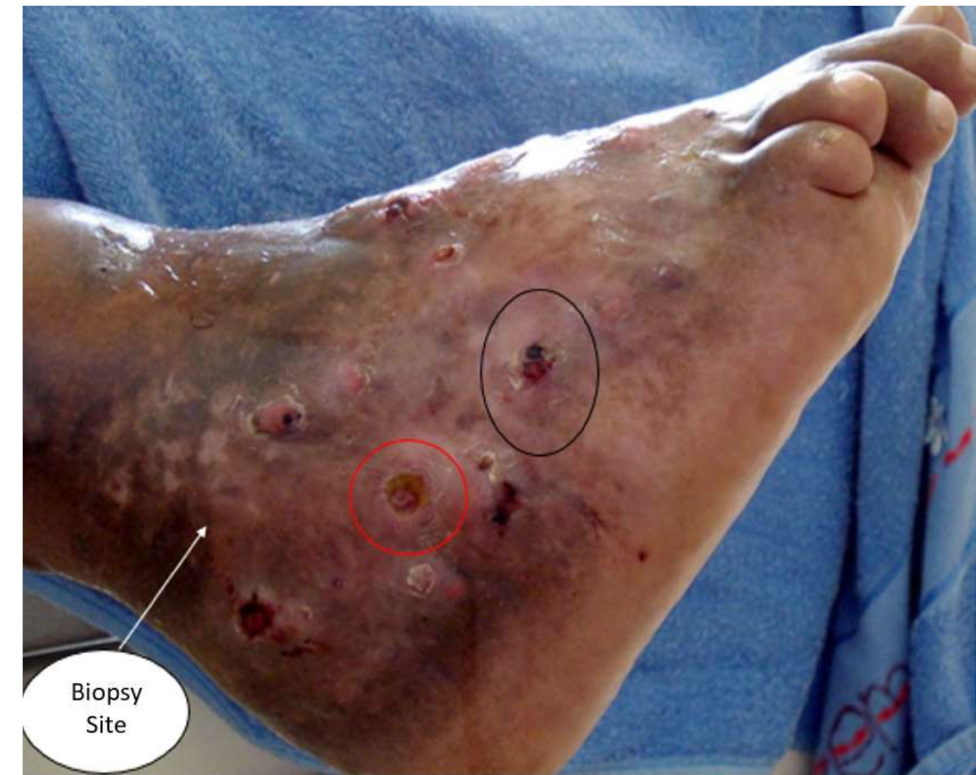
Figure 1. Clinical picture of the patient’s right foot, with diffuse nodular lesions, extensively affecting the cutaneous and subcutaneous plane, of variegated color (from yellowish to dark and red), with hardened and multiple base vesicles subcutaneous abscesses, which, after rupture, resulted in real superficial skin sinuses (red and black circle): white arrow, site of skin biopsy.